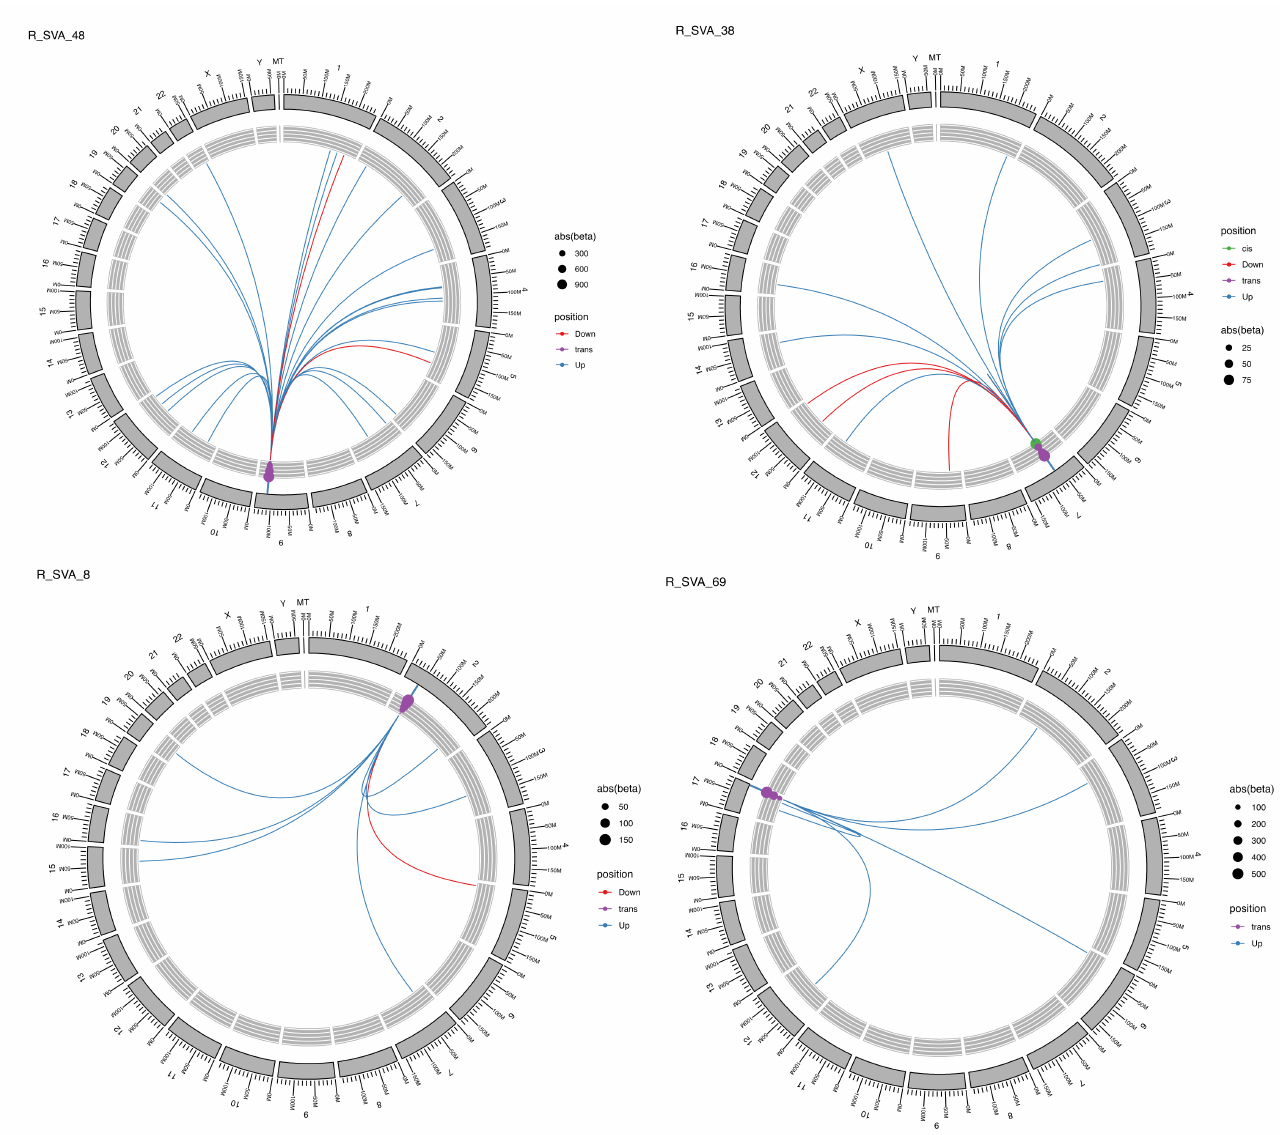
Figure 4. Circos plots showing the targets and effects for four different SVAs. Blue line is for up-regulation; red line is for down-regulation of the gene. Dot size is beta value; dot colour is trans or cis